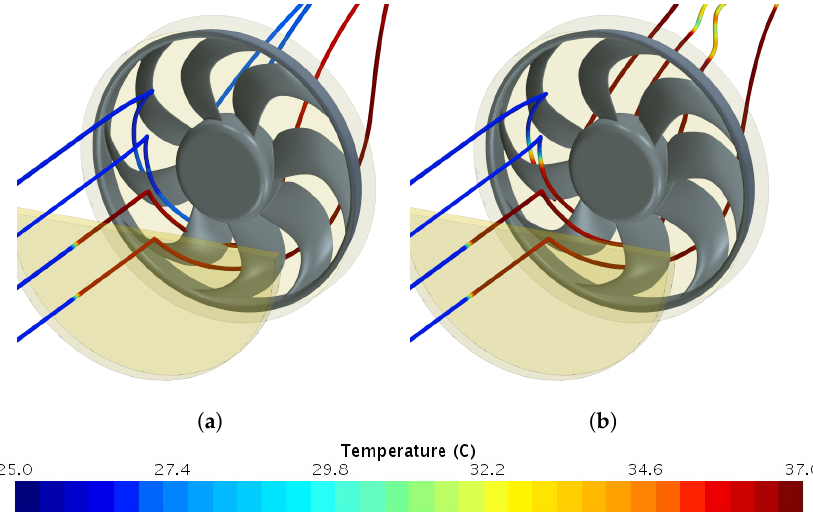
Figure 5. Streamlines of the relative velocity coloured by temperature. ( a ) MRF; ( b ) RBM.